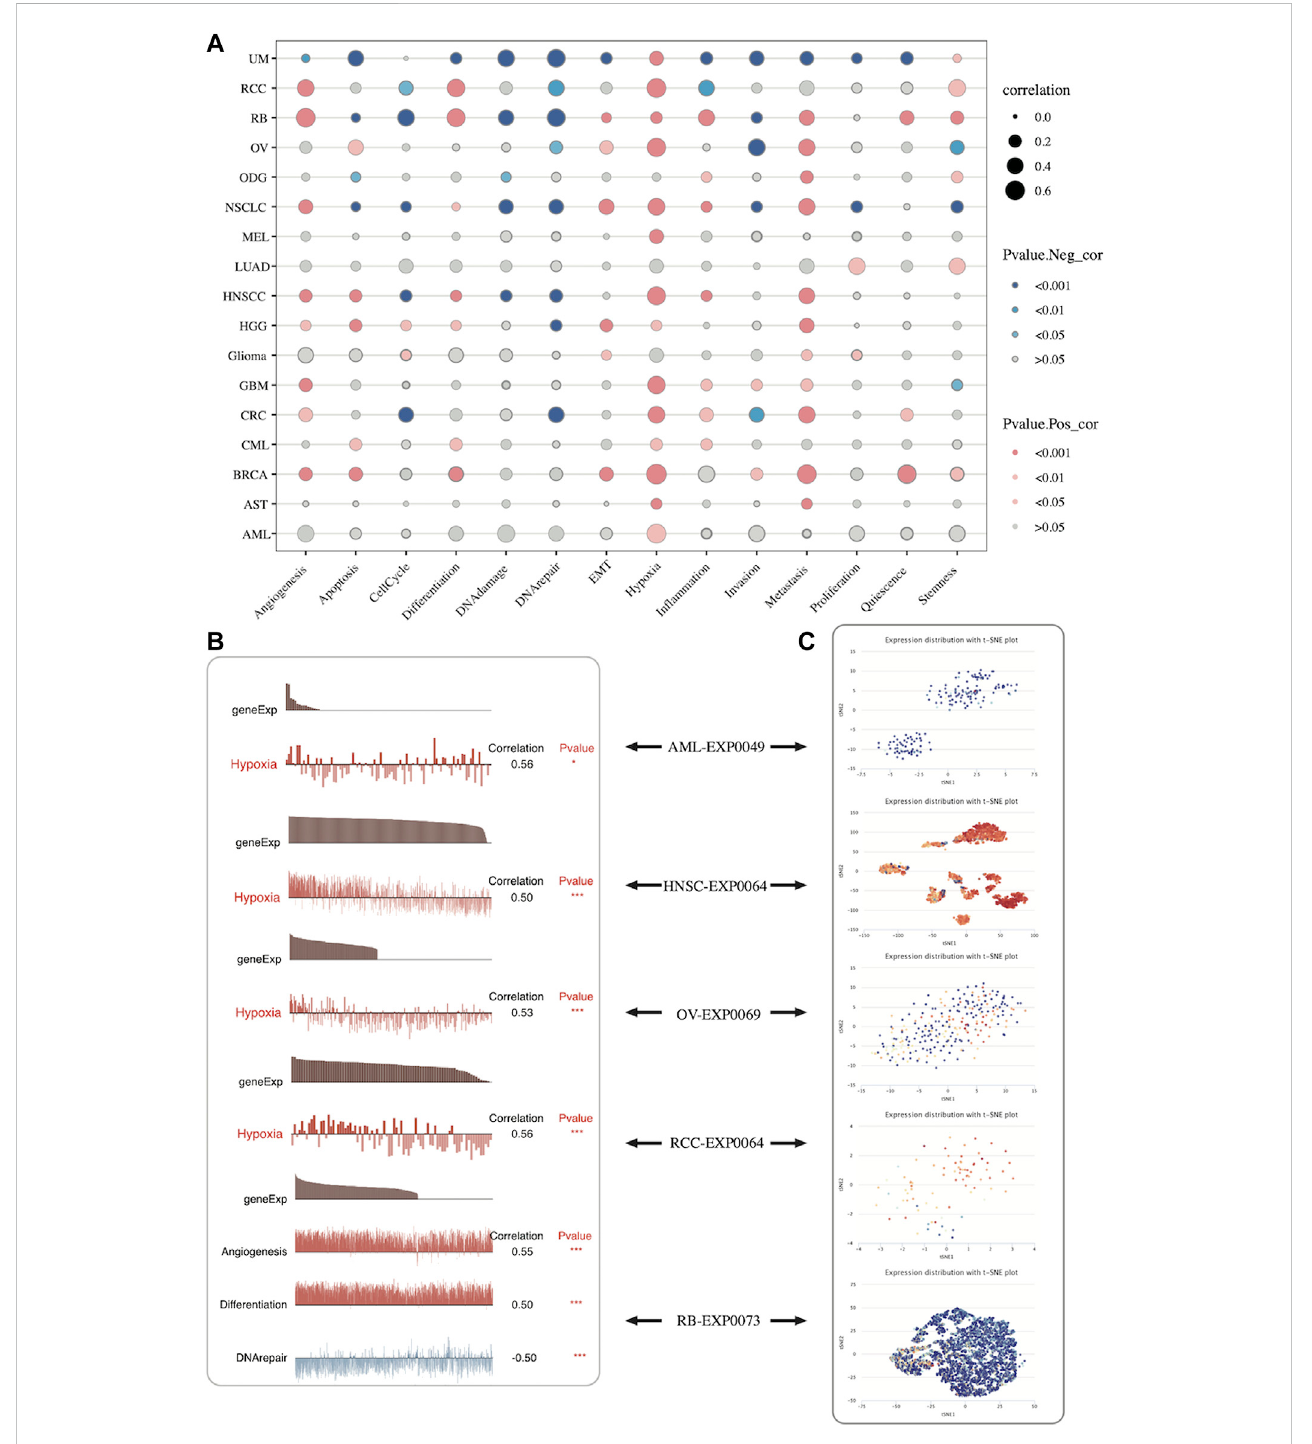
FIGURE 12 Expression pattern of SLC2A1 at the single-cell level and its relationship with the tumor-related biological functional status according to CancerSEA database (A) The correlation between SLC2A1 expression and different tumor functional status across pan-cancer (B) The correlation between SLC2A1 expression and different tumor functional status in individual datasets (C) SLC2A1 expression distribution of AML-EXP0049, HNSC-EXP0064, OV- EXP0069, KIRC-EXP0064 and RB-EXP0073 were shown at single-cell levels by t-SNE